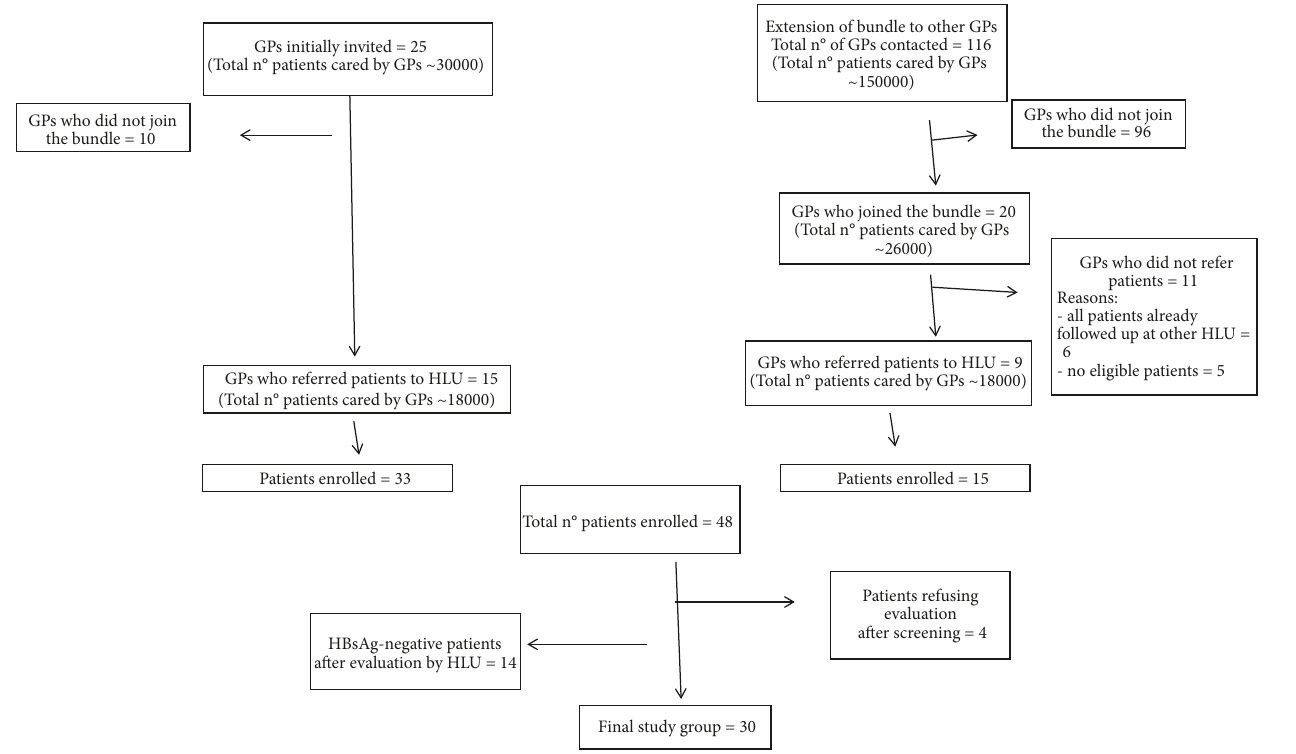
Figure 2: GP involvement in the